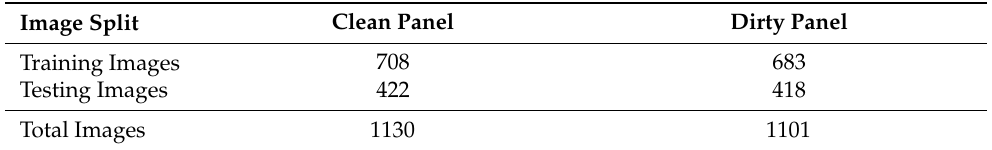
Table 1. Train–Test split of